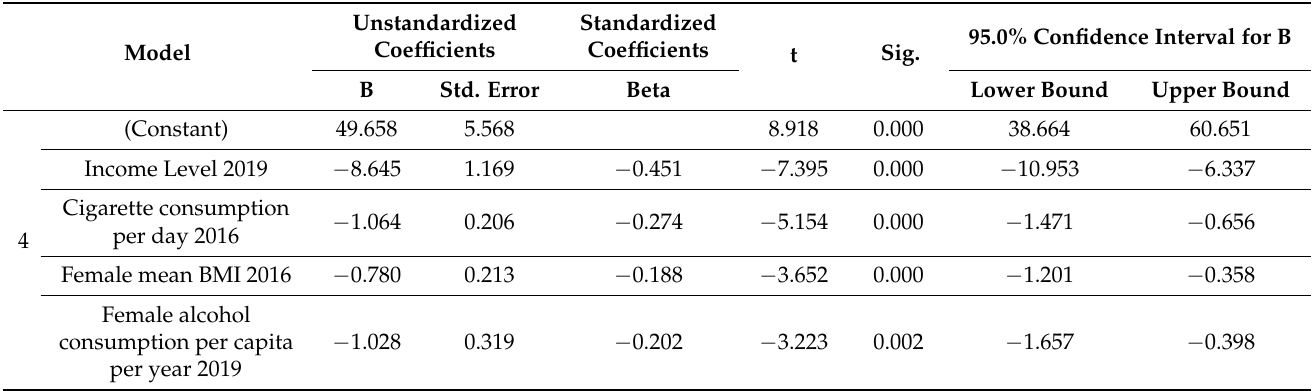
Table 7. Coefficients of the estimated regression